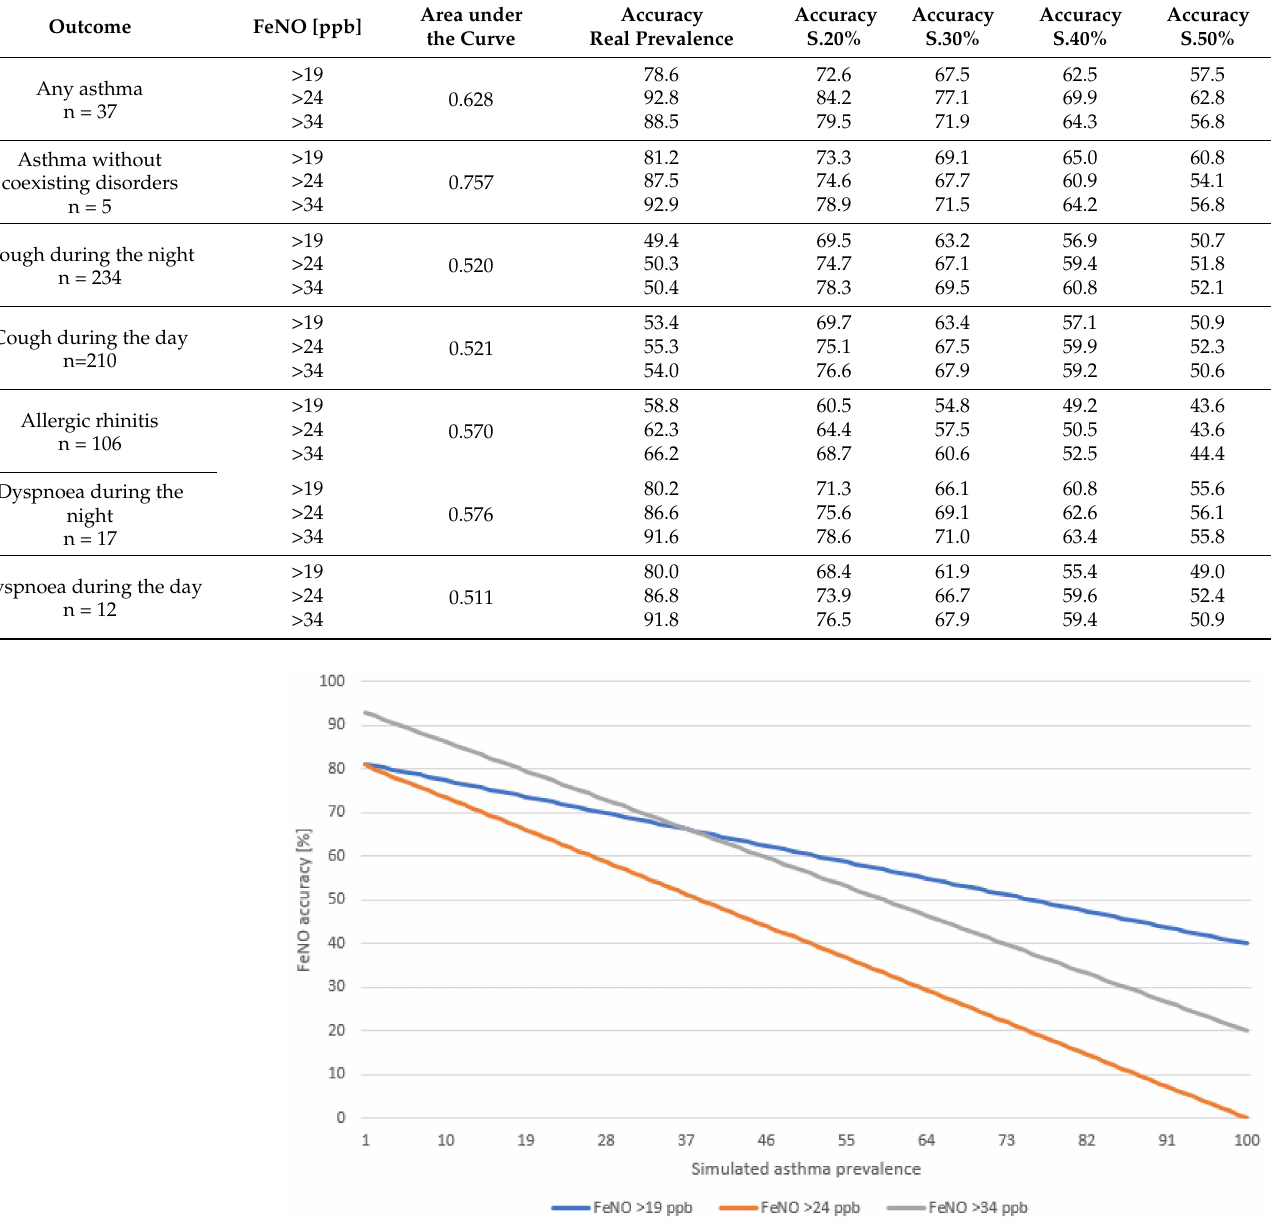
Figure 1. FeNO accuracy in epidemiological asthma diagnosis presented with the simulated preva- lence of asthma and three FeNO